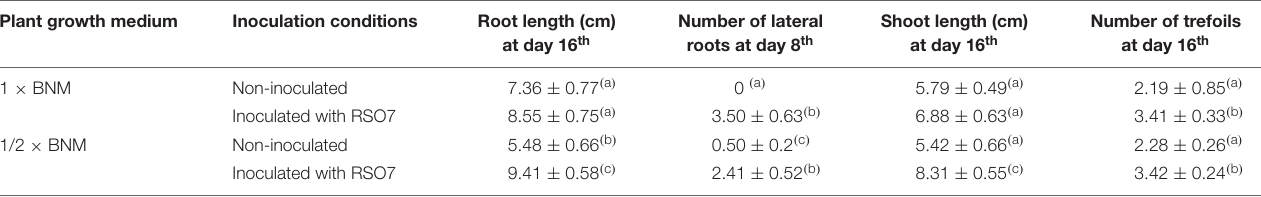
Number of lateral Shoot length (cm) at day 16 th roots at day 8 th at day 16